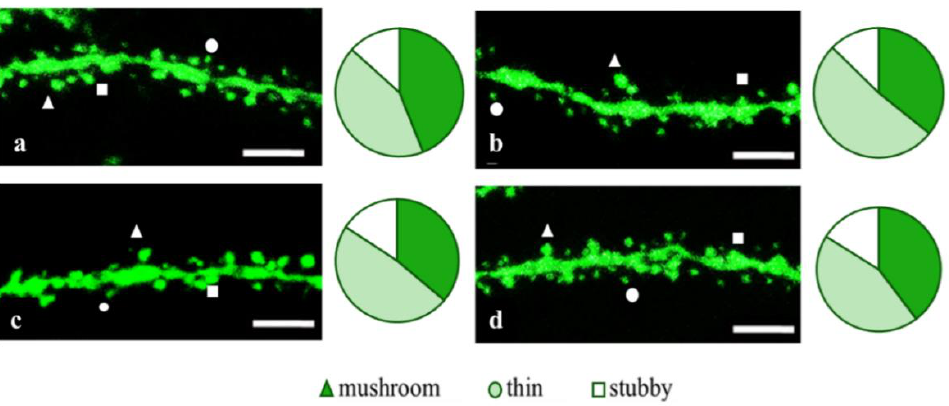
Figure 8. Confocal images of the CA1 secondary dendrites in 5 month-old female M ( a ) end 5xFAD- M mice injected with a physiological solution ( b ), EDR peptide ( c ), KED peptide ( d ). Confocal microscopy, ×100. Scale bar, 10 μm.